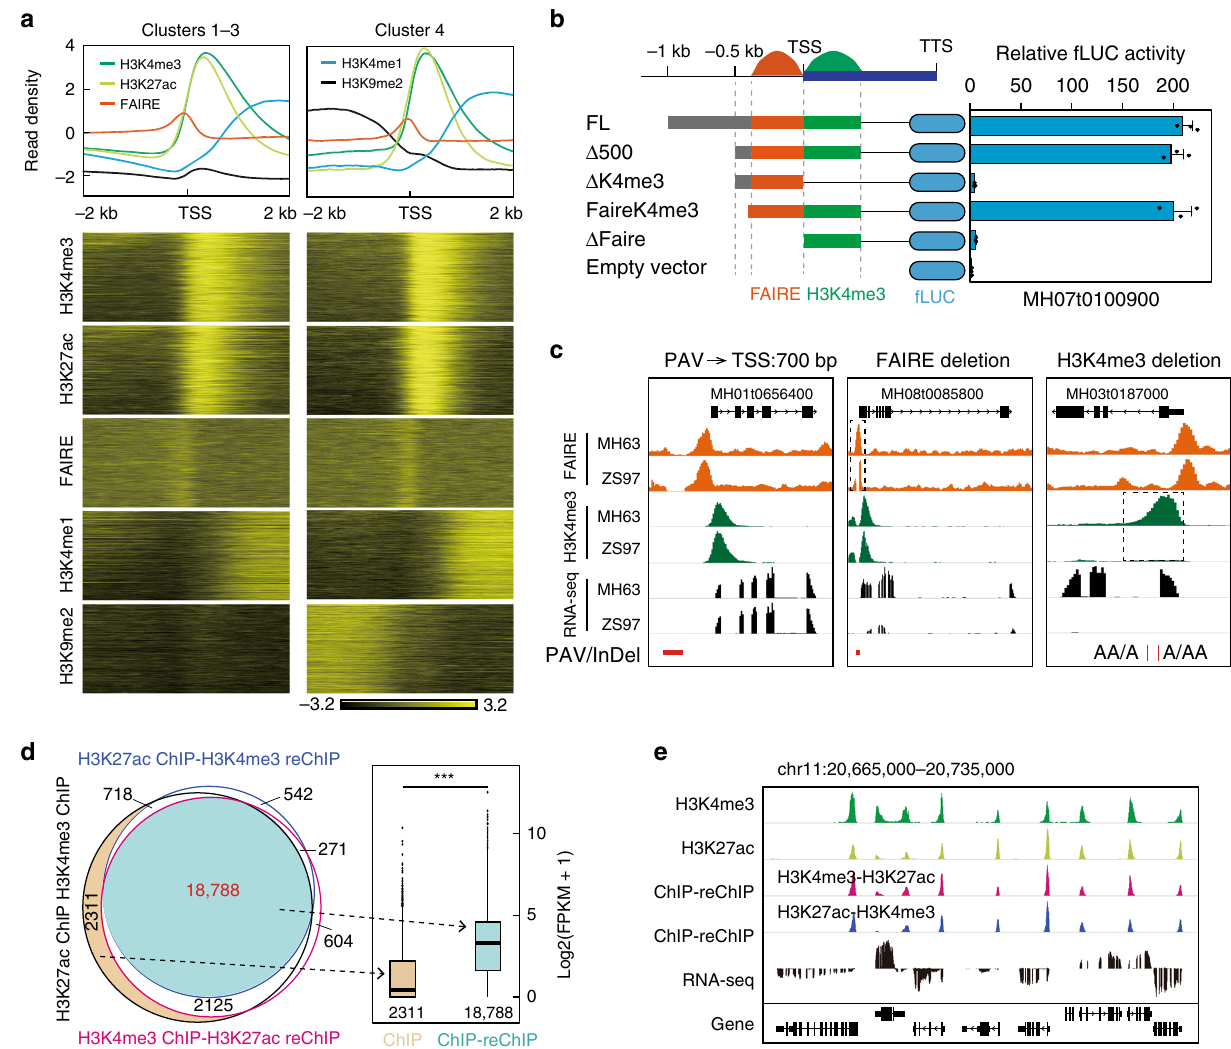
Fig. 3 Epigenetic features of rice promoters and associated transcription patterns. a Comparison of promoter Clusters 1 − 3 and Cluster 4, de fi ned by epigenetic modi fi cation patterns around promoters in Supplementary Fig. 7. b The re fi nement of promoter regions with H3K4me3 modi fi cation and open chromatin signal on transcription activation. A transient reporter assay was used to examine the effects of different promoter regions on gene expression in rice protoplasts. Left, schematic representation of fLUC reporter constructs fused with the full-length promoter (FL) and deletion variants ( Δ 500, Δ K4me3, FaireK4me3, and Δ Faire). Each value represents the mean ± standard error of mean ( n = 3 biological replicates). Empty vector served as the negative control. Gene MH07g0100900 serves as a representative example. c Representative examples for transcription effects of promoter length, open chromatin, and H3K4me3-modi fi ed regions on transcription activity, validated by the presence of InDels and PAVs between MH63 and ZS97. Dotted boxes represent the regions with deleted peaks of FAIRE or H3K4me3 in ZS97. d Validation of co-occupation for H3K4me3 and H3K27ac using ChIP- reChIP. Venn diagram (left panel) showing the overlap of H3K4me3 and H3K27ac co-occupation sites dedicated using ChIP-reChIP-Seq and ChIP-Seq, respectively. Boxplots (right panel) for expression levels of the indicated gene category. Boxplots show the median, third and fi rst quartiles. *** p < 0.001 from Wilcoxon test. The numbers indicate the sample size used in the analysis. e Genome browser screenshot showing H3K4me3- and H3K27ac- commodi fi ed genes. Source Data underlying Fig. 3b, d are provided as a Source Data fi